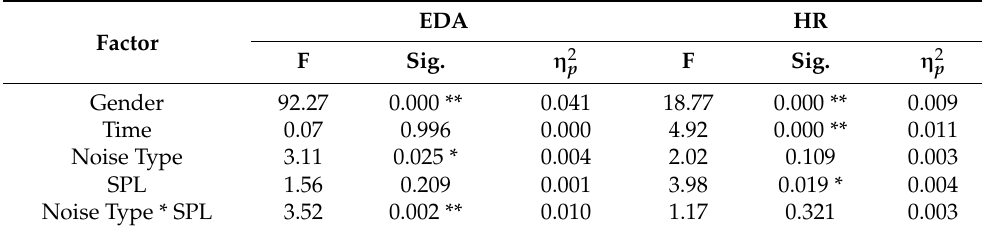
Table 2. MANOVA analysis of physiological responses to traffic sounds. * and ** represent significant differences at 0.05 and 0.01 level, respectively.